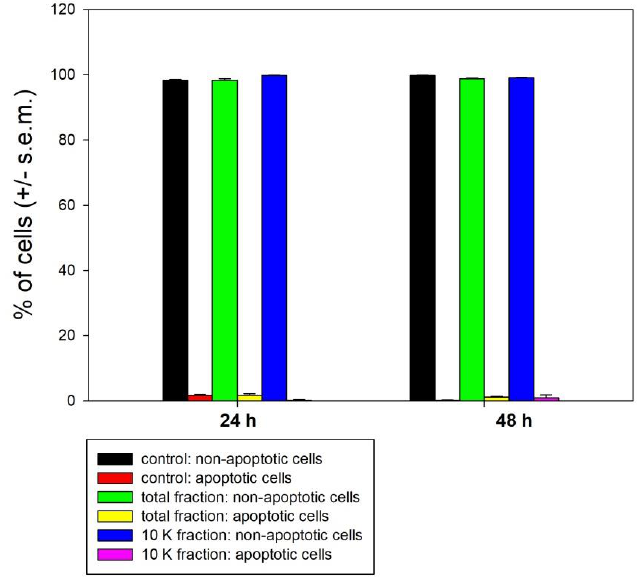
Figure 4. Histograms showing the percentage of apoptotic (annexin V+/propidium iodide−) vs. non-apoptotic MDA-MB-231 cells cultured in control conditions or exposed to either total extracts or 10K fractions for 24 and 48 h. Error bars correspond to the standard error of the mean (s.e.m.) of three independent measurements. * p < 0.05.